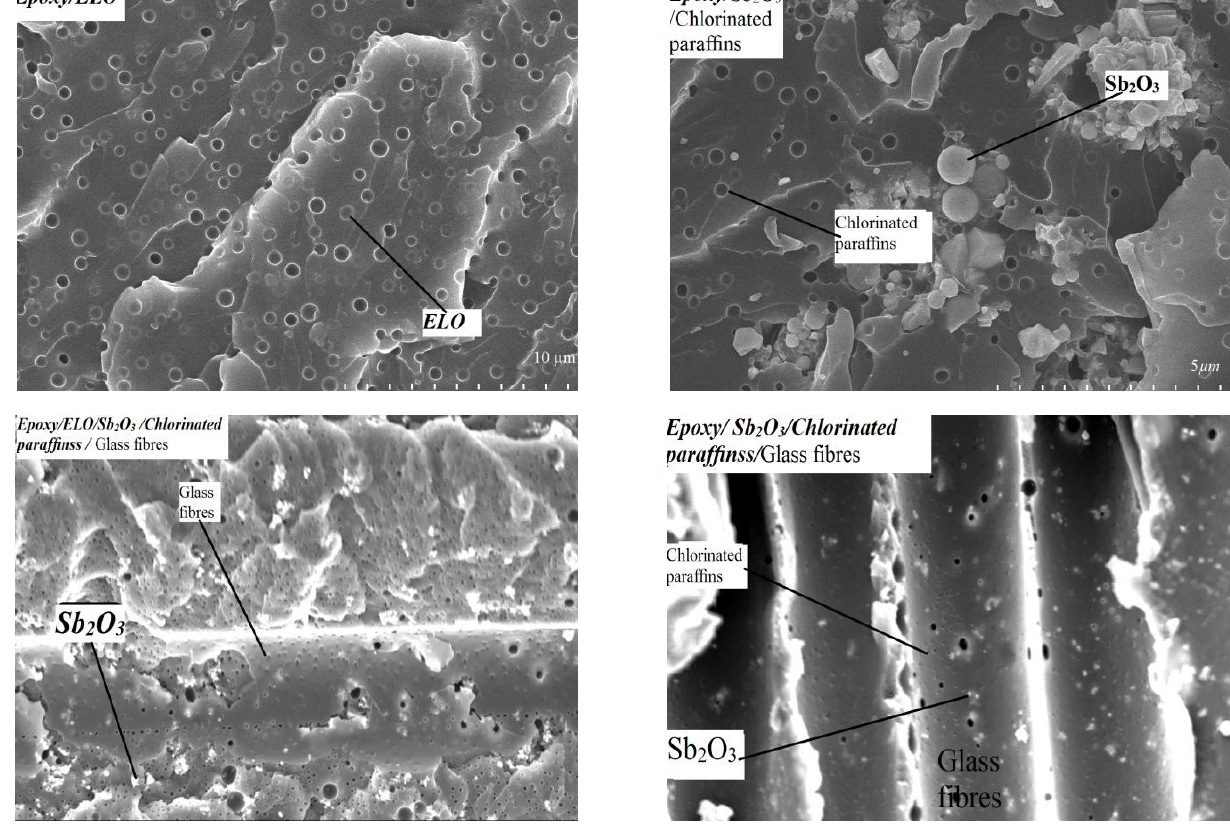
FIG. 8. FE-SEM MICROGRAPHS OF THE SAMPLES: EPOXY/ELO/ SB PARAFFINS/ GLASS FIBRES;